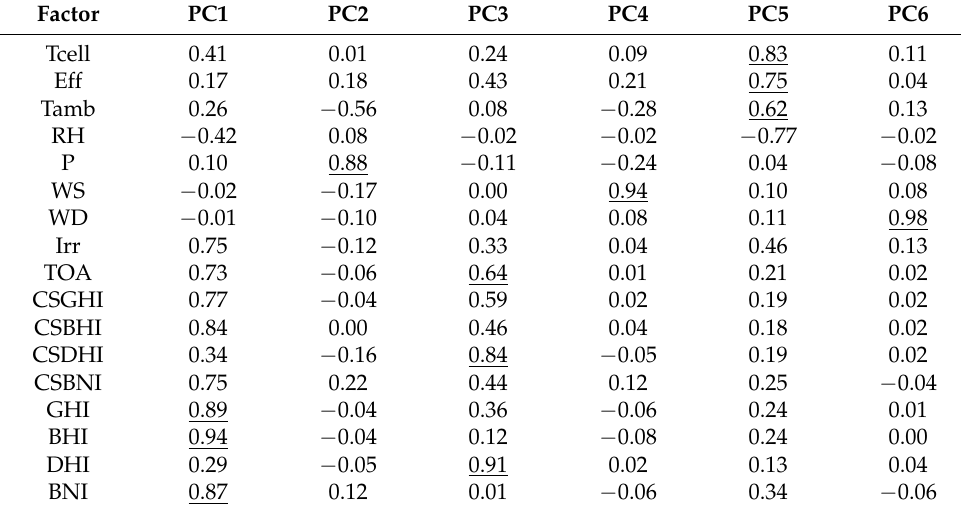
Table 5. Results of PCA.